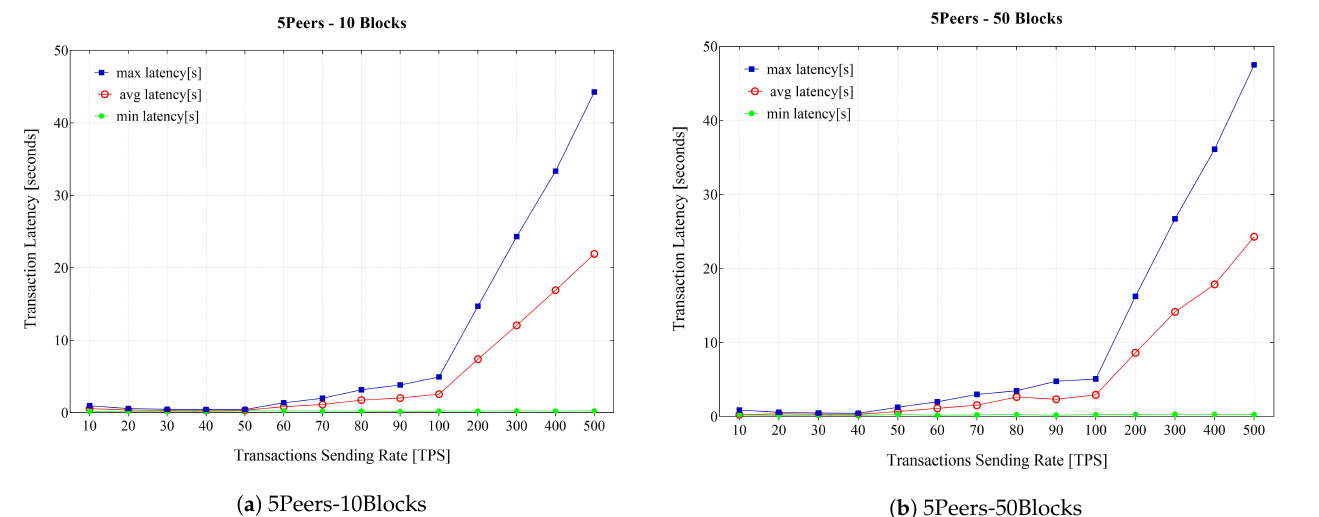
Figure 11. Latency vs. transaction sending